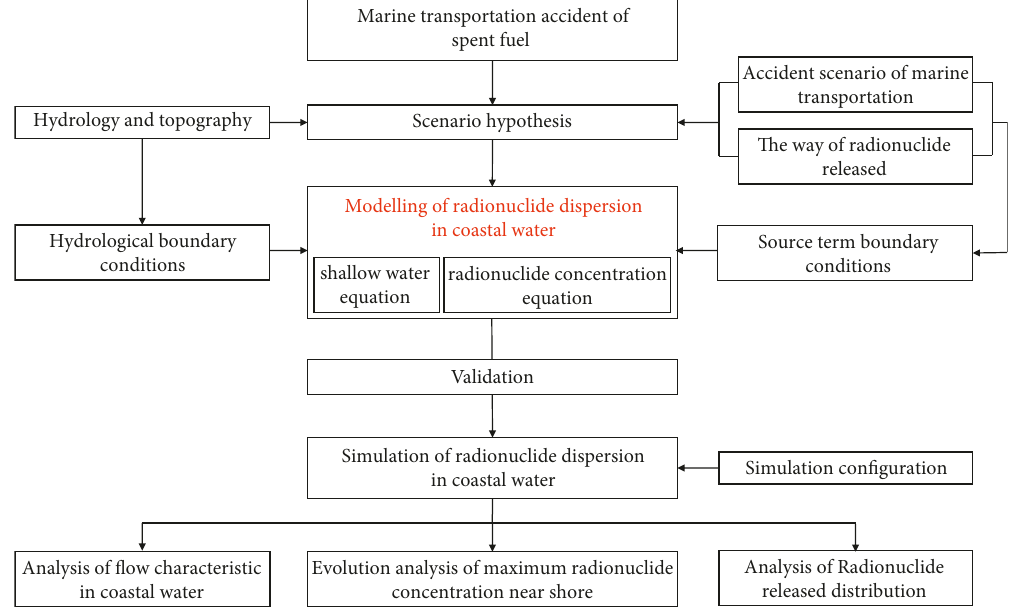
Figure 1: Simulation procedure of radionuclide dispersion in coastal